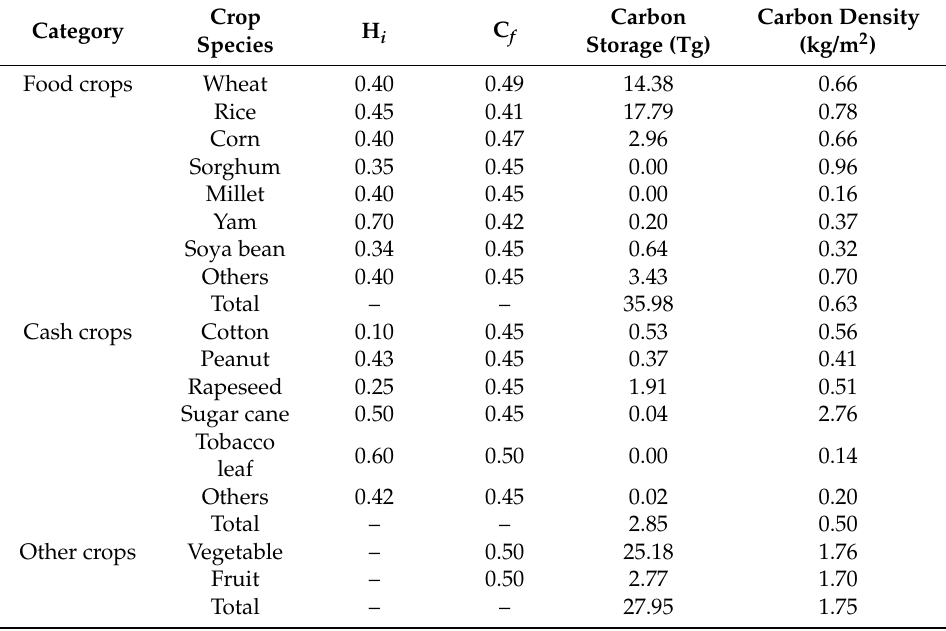
Table 1. The carbon storage and carbon density of each crop in the Jiangsu